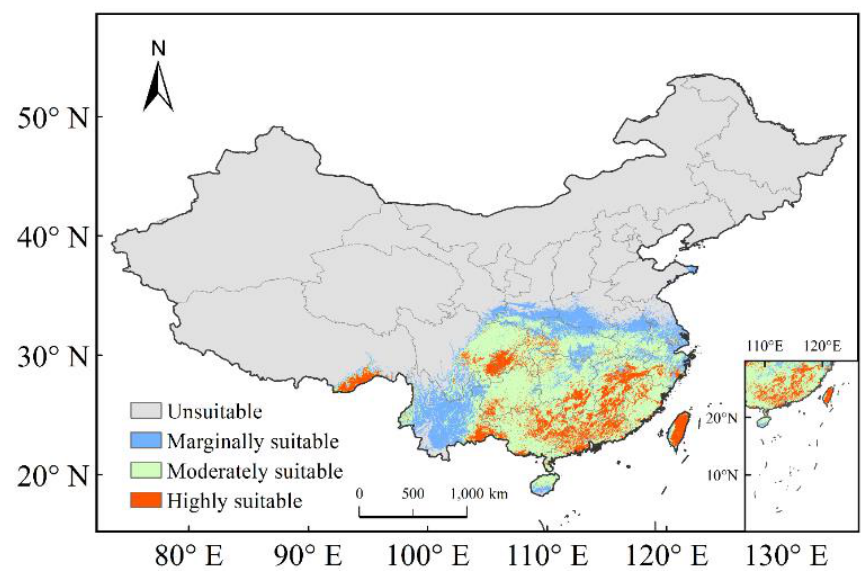
Figure 5. Current potential suitable areas for C. lanceolata in China.